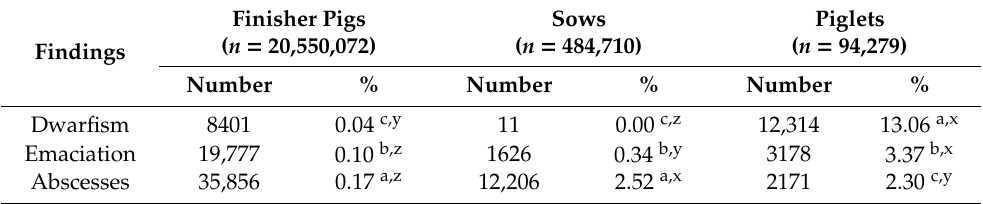
Table 7. Comparison of the number of overall changes in finisher pigs, sows and piglets slaughtered in the